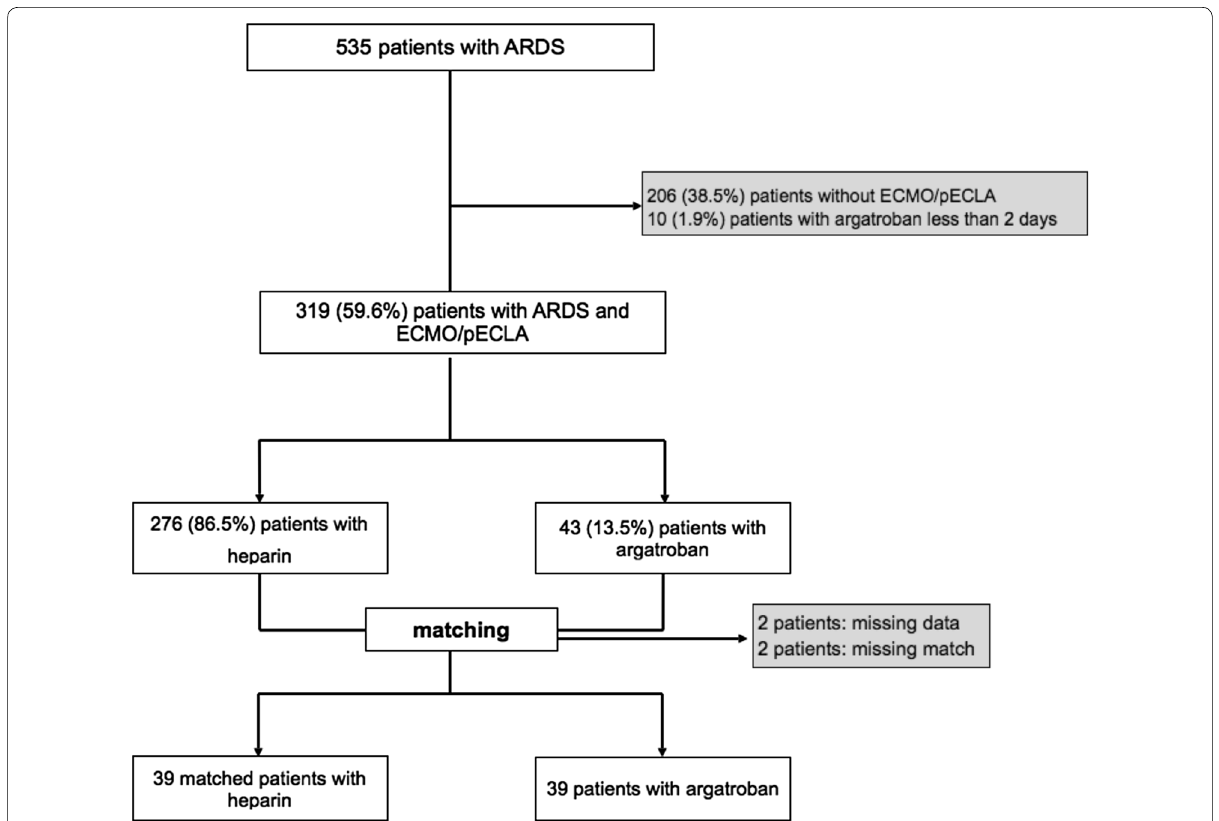
Fig. 1 Study population and recruitment of the matched